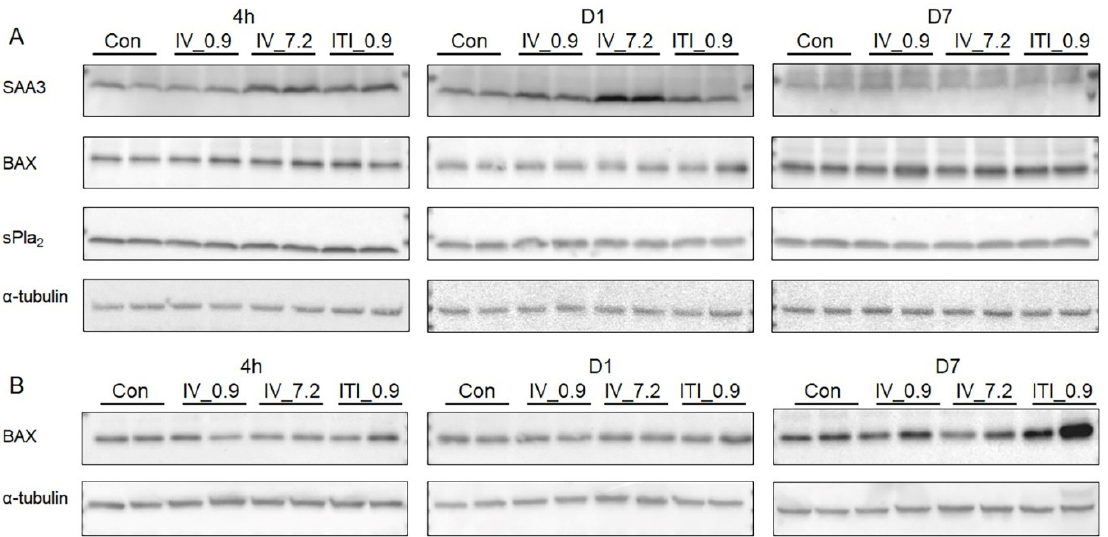
Figure 7. Measurement of protein expression levels in the liver and lung tissues: Protein levels of SAA3, BAX, and sPLA 2 in the liver lysates ( A ) and BAX in the lung lysates ( B ) were measured using Western blotting. α –Tubulin was used as a loading control.